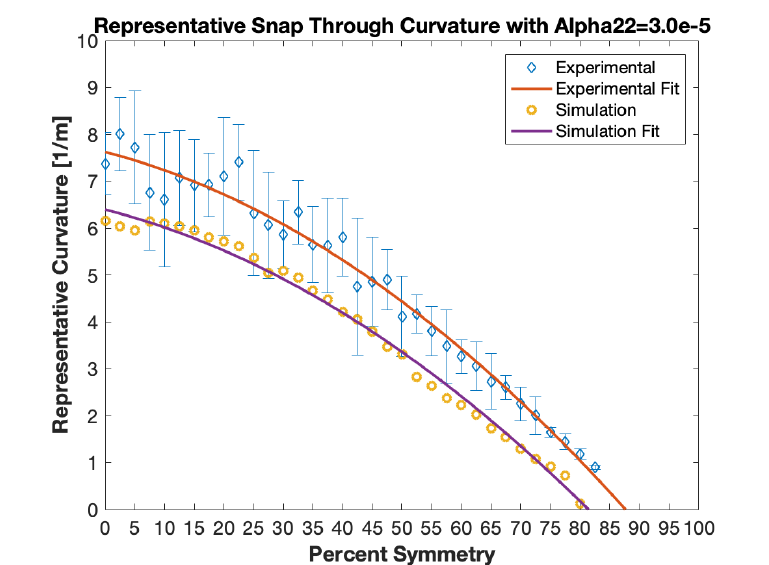
Figure 13. The snap through curvature versus the percent symmetry for all of the laminates simulated and studied that were bistable, using an α 22 value of 3.0 × 10 − 5 . Error bars on the experimental points show ± one standard deviation.